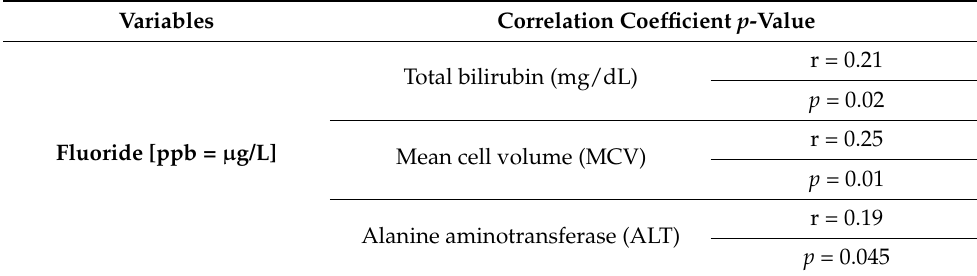
Table 4. Correlation between serum fluoride concentration and total bilirubin, MCV, ALT. Variables